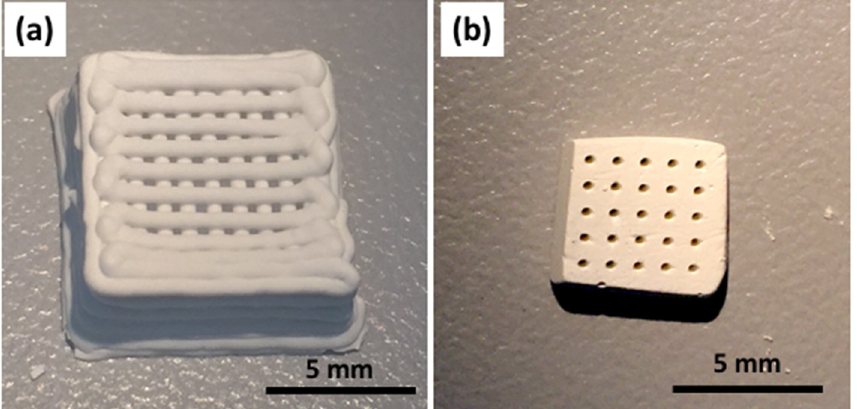
Figure 2. Optical images of 3D macropore structures. ( a ) SG40TCP60-RC scaffold, manufactured by robocasting and ( b ) SG40TCP60-LM, fabricated by laser micromachining (2-millimeter thickness).